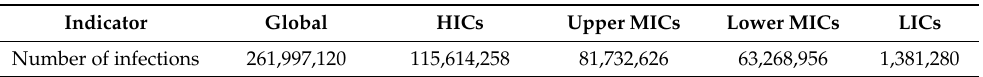
Table 2. Global estimates of global SARS-CoV-2 infections as of 1 December 2021, derived from Ritchie et al.